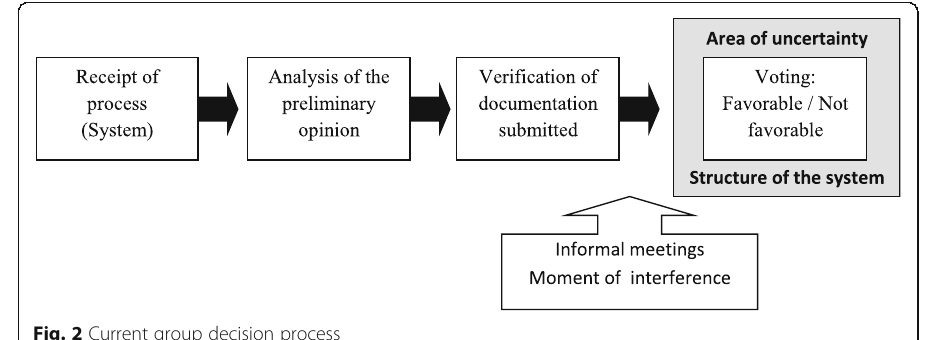
Fig. 2 Current group decision